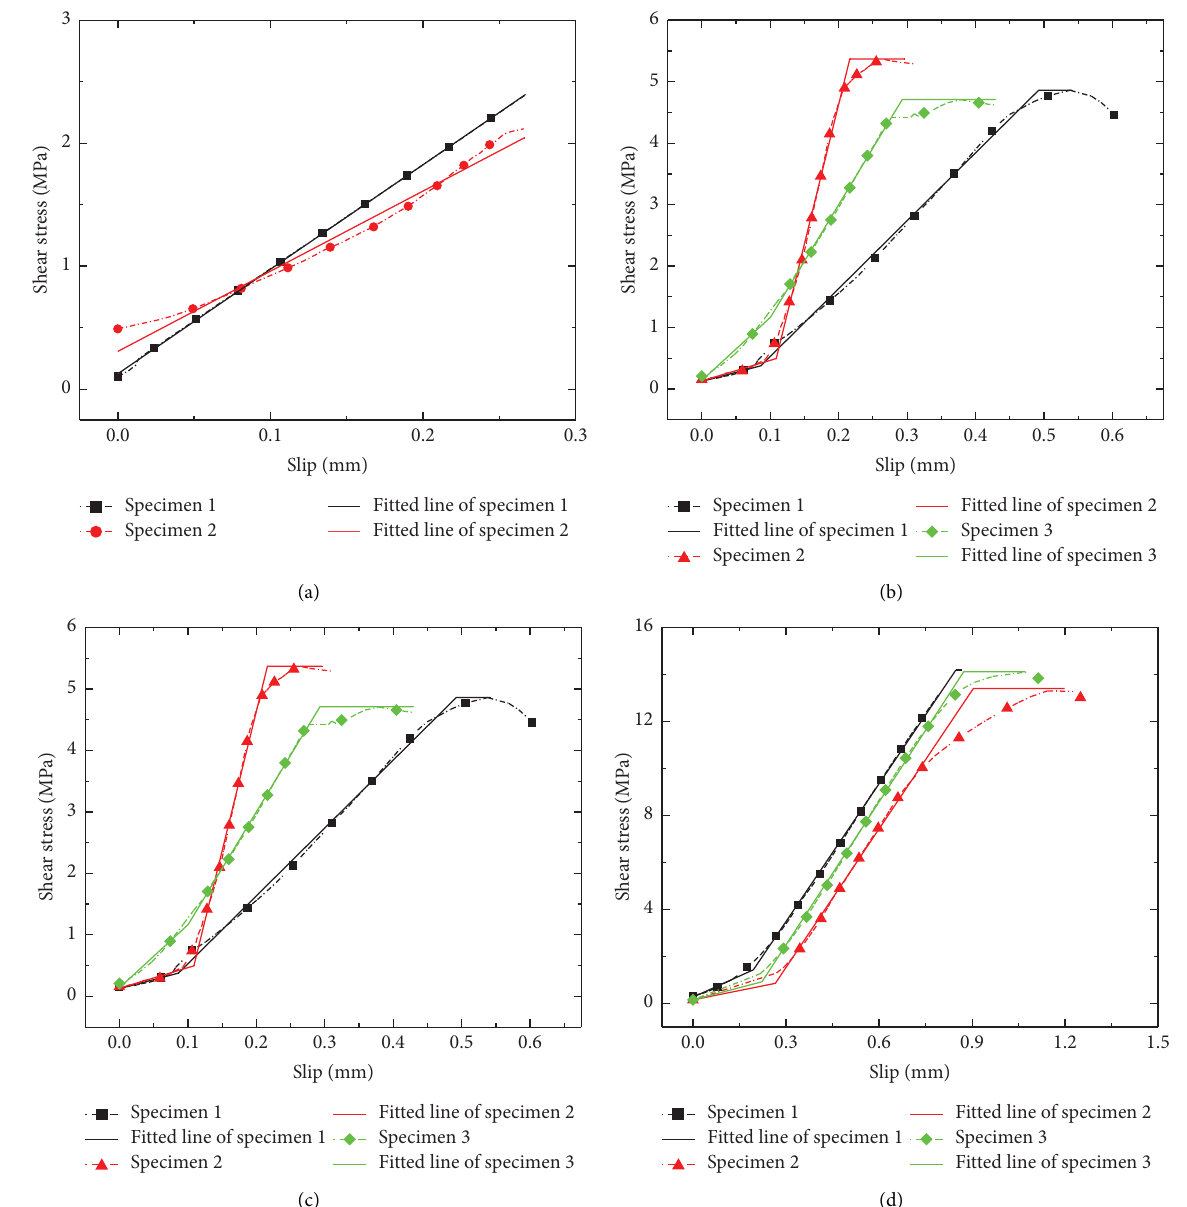
Figure 10: Bond stress-slip of slant shear specimens. (a) No shear keyway. (b) One shear keyway. (c) Two shear keyways. (d) Tree shear